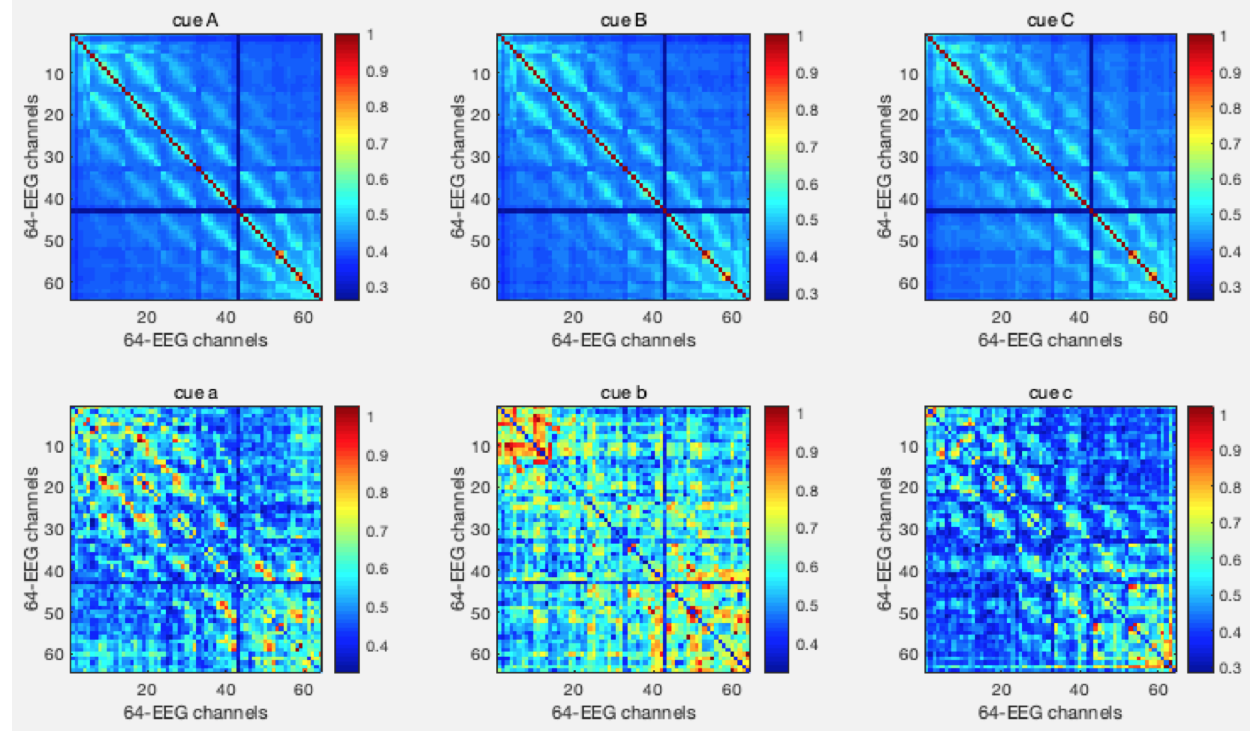
Figure 9. Symmetric mutual information matrices.